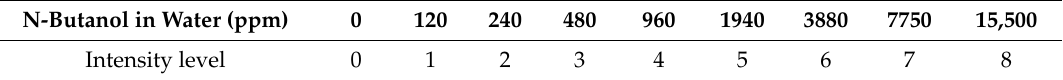
Table 1. ASTM standard 8 point n-butanol odour intensity reference scale [18].